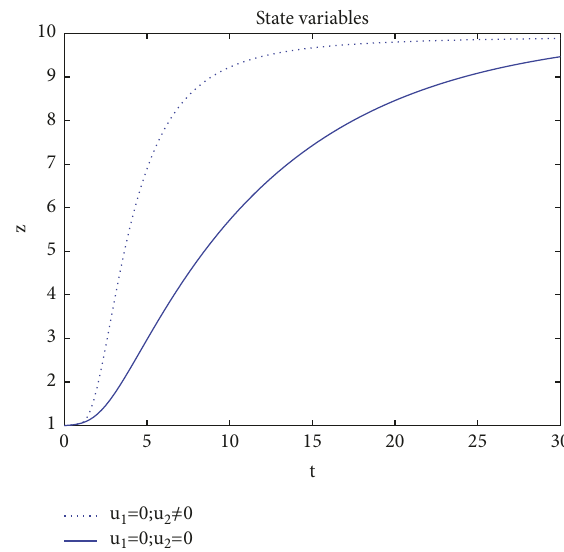
Figure 5: Evolution of number of 𝑥(𝑡) with or without control.